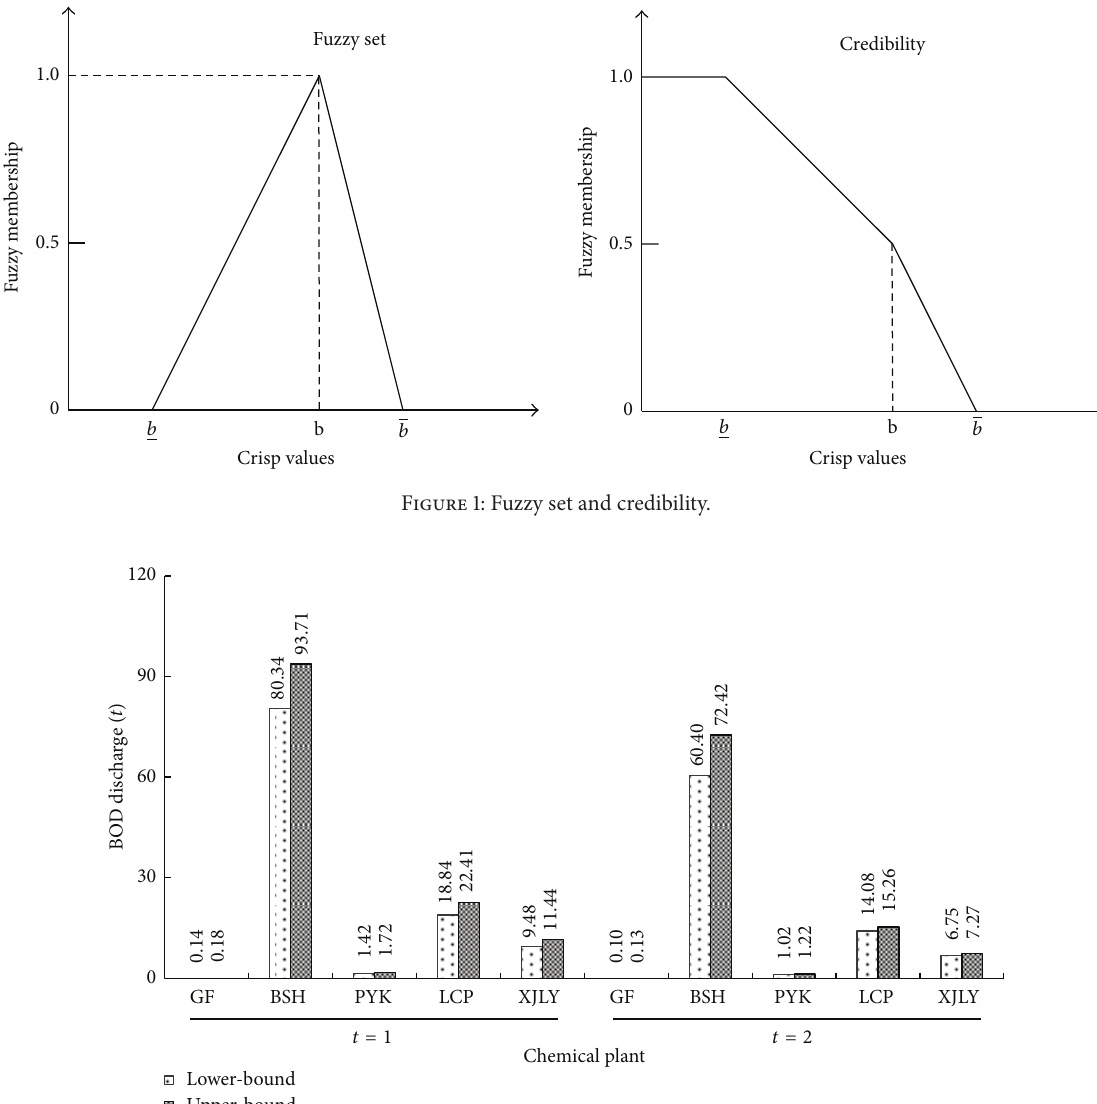
Figure 1: Fuzzy set and credibility.